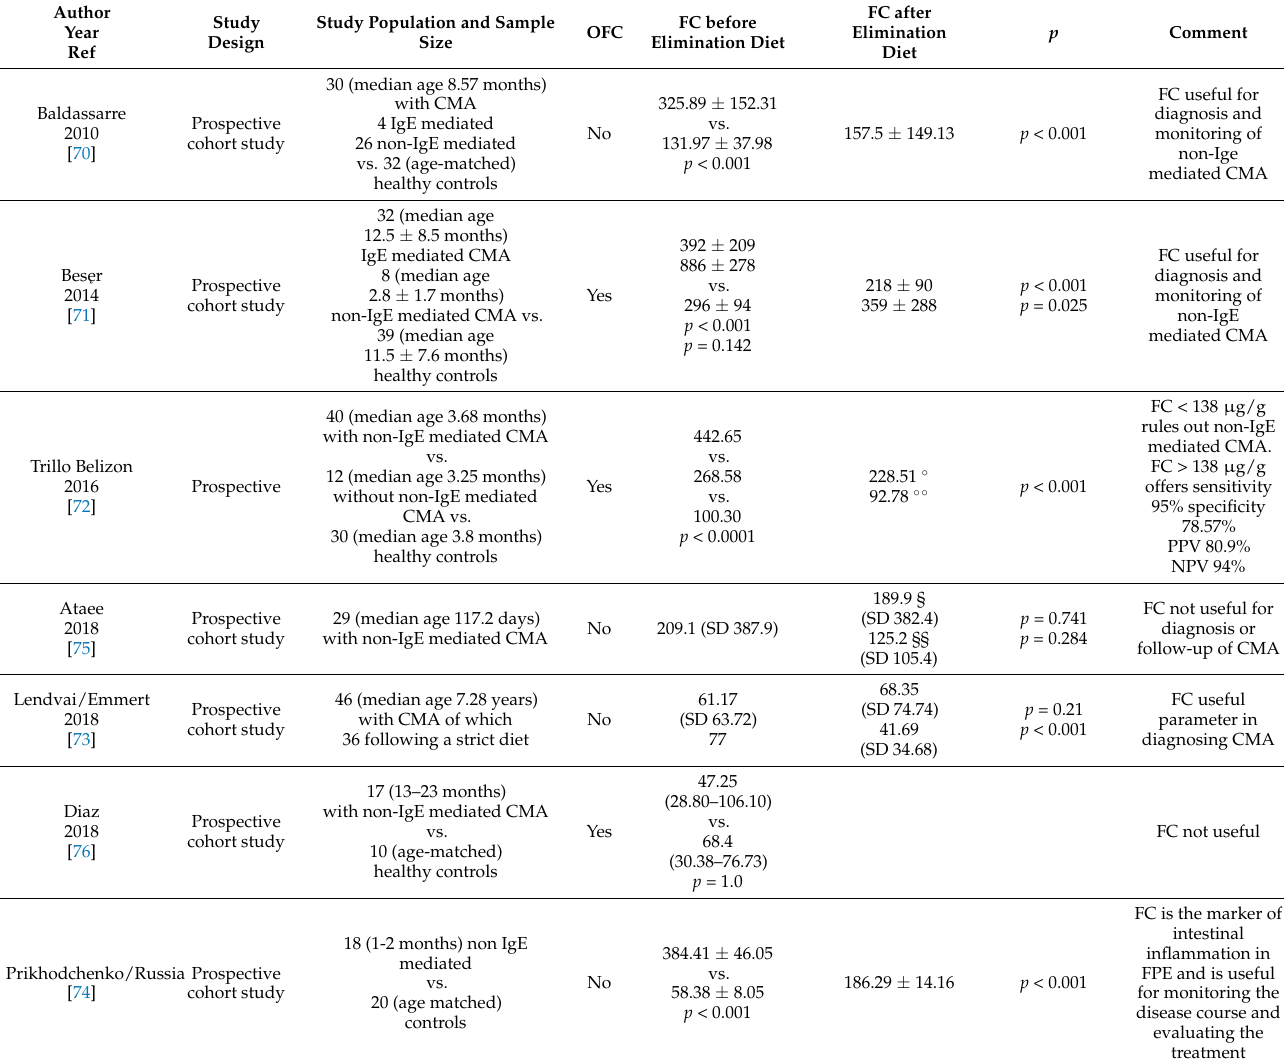
Table 3. Fecal calprotectin in the diagnosis of